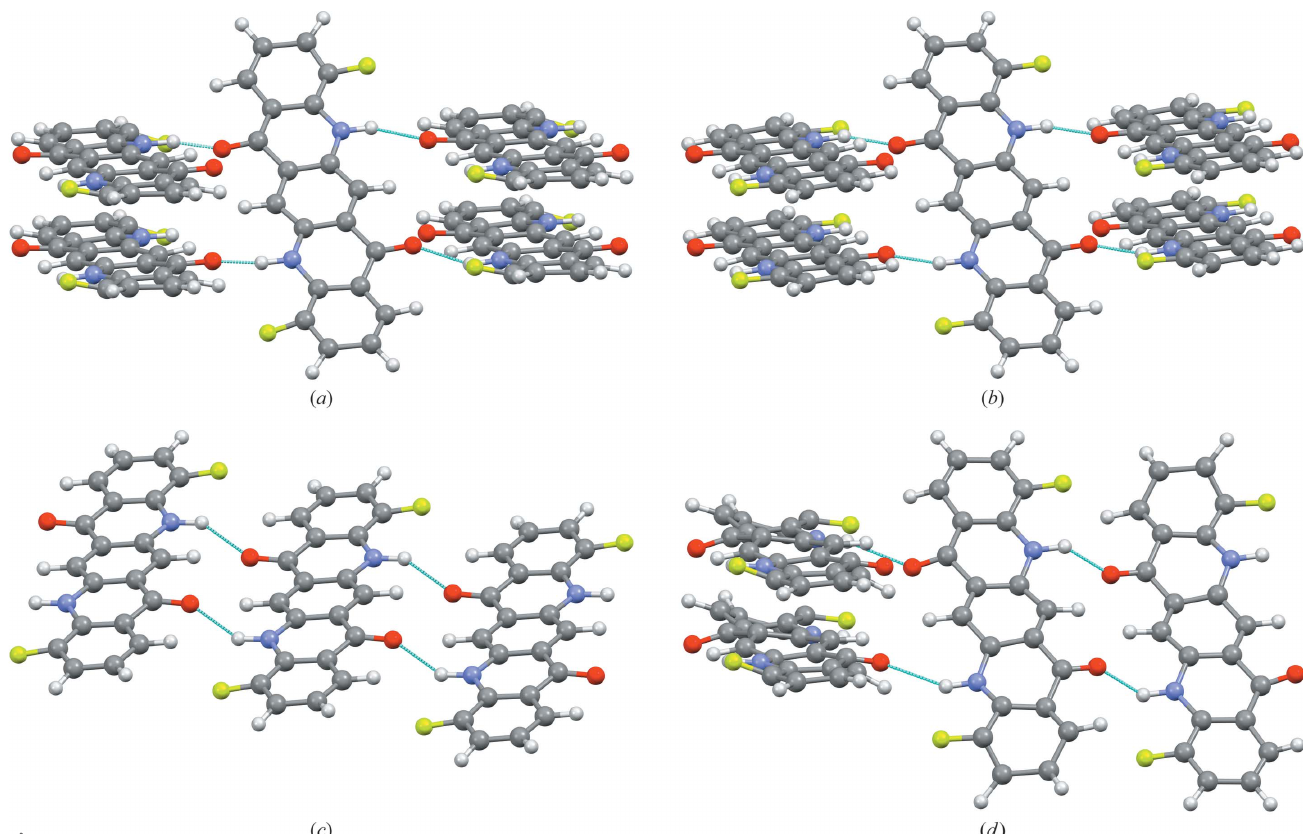
Figure 3 Molecular geometry and hydrogen bond patterns in the models ( a ) A, ( b ) B, ( c ) C and ( d ) D, after user-controlled Rietveld refinement. Colour code in all drawings: C grey, H white, F yellow, N blue, O red. Hydrogen bonds are drawn as blue dotted